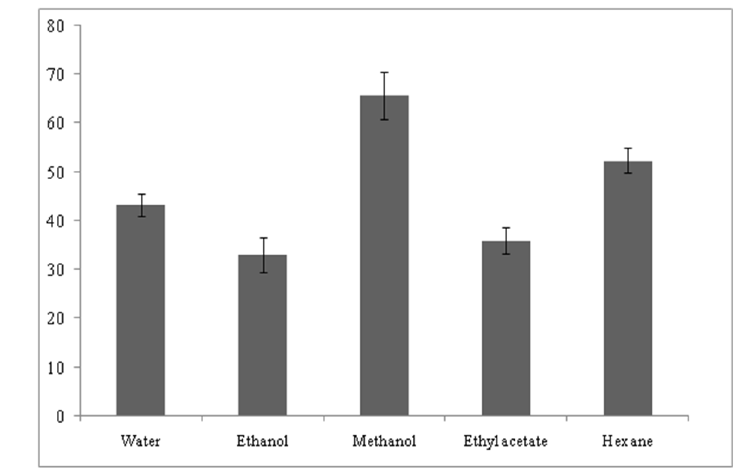
Figure 1. α -Amylase inhibitor activity extracted from Moringa oleifera using different solvents. 2.2. Purification of α -Amylase Inhibitor from Moringa oleifera ( α AI.Mol) The purification flow sheet is summarized in Table 2. Table 2. Flow sheet of α -amylase inhibitor purification.